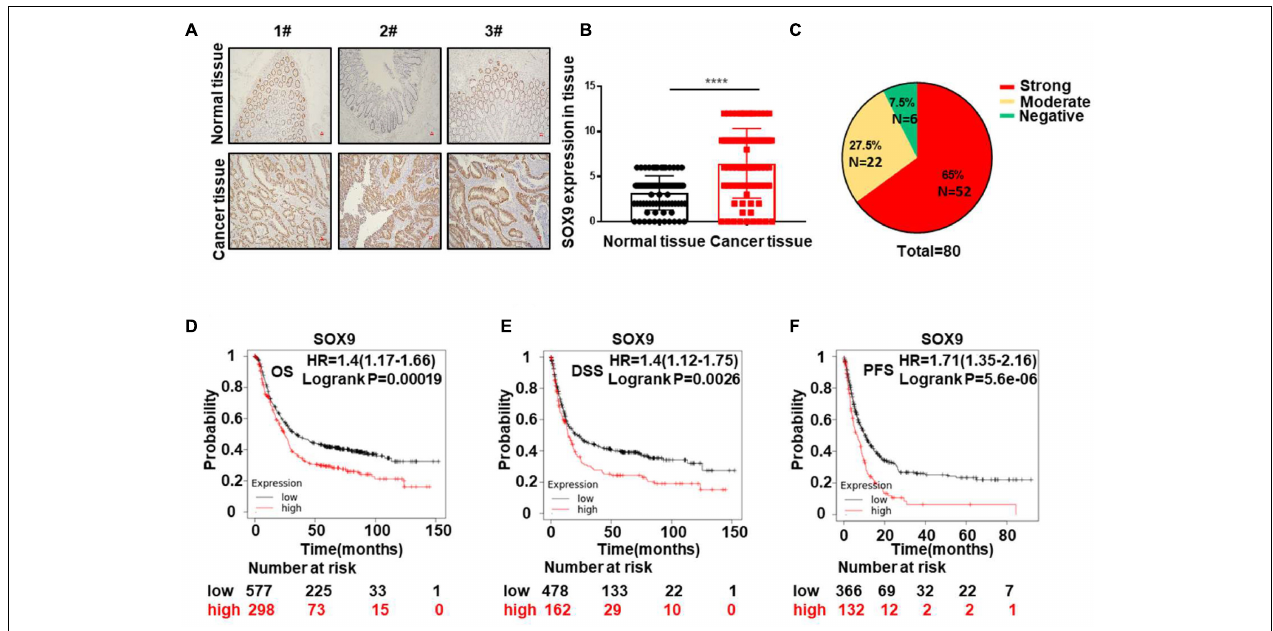
FIGURE 1 | SOX9 is aberrantly highly expressed in tumor tissues and predicts poor prognosis in CRC. (A) Representative IHC staining image of the expression of SOX9 in three pairs of CRC tissues (T) and paired adjacent normal tissues (N). Scale bar = 50 µ m. (B) Quantitative analysis of SOX9 expression in 80 CRC tumor tissues (T) and adjacent normal tissues (N). (C) Percentages of negative, moderate, and strong SOX9 expression in CRC tumor tissues ( n = 80). (D–F) Kaplan–Meier analysis of the overall survival (OS) (D) and disease-specific survival (DSS) rates. (E) Progression-free survival (PFS) (F) in CRC patients with SOX9 low and SOX9 high tumors in the TCGA database. * P < 0.05, ** P < 0.01, and **** P <